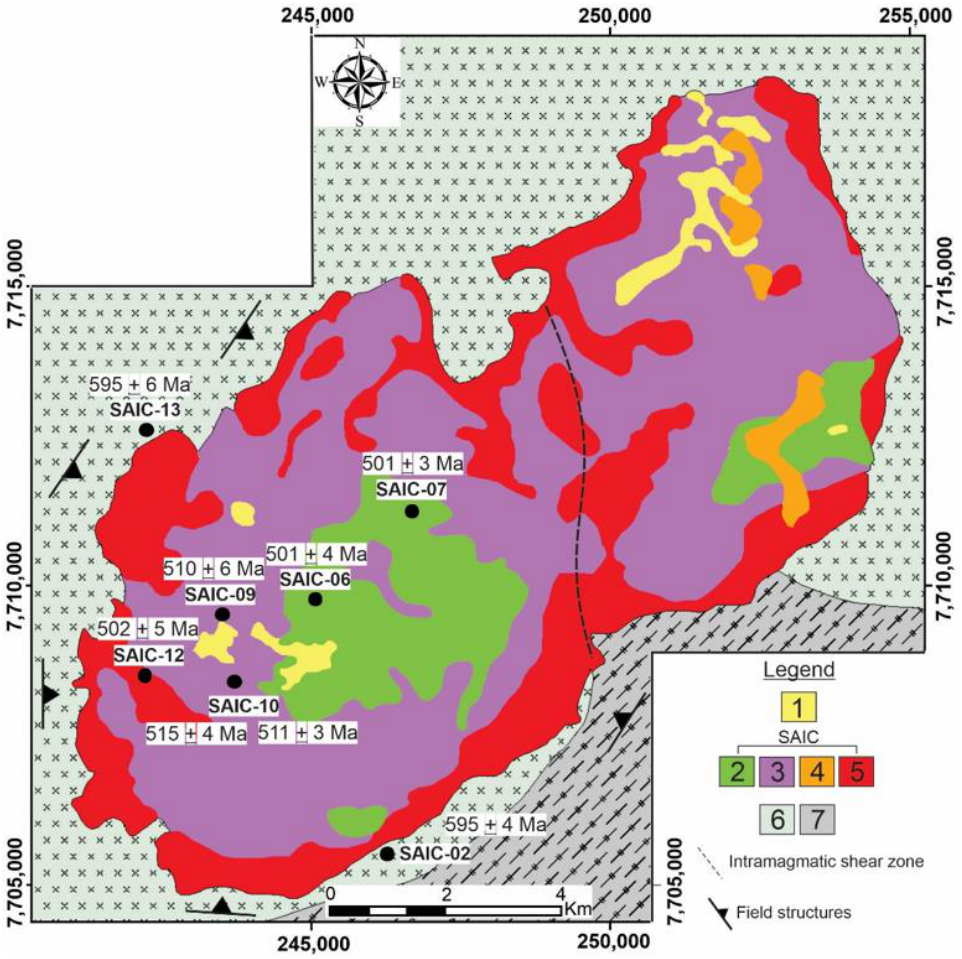
Figure 2. Geological map of the Santa Angélica Intrusive Complex (SAIC). Legend: (1) Cenozoic sediments; (2) Gabbro/Norite; (3) Hybrid Zone; (4) Granite type 2; (5) Granite type 1; (6) Orthogneiss Muniz Freire; and (7) Paragneisse Bom Jesus do Itabapoana. The points plotted on the map represent the locations (in outcrops) where the SAIC samples studied in this work were collected. Source: Adapted from [21]. The presented U-Pb ages were obtained in this work.